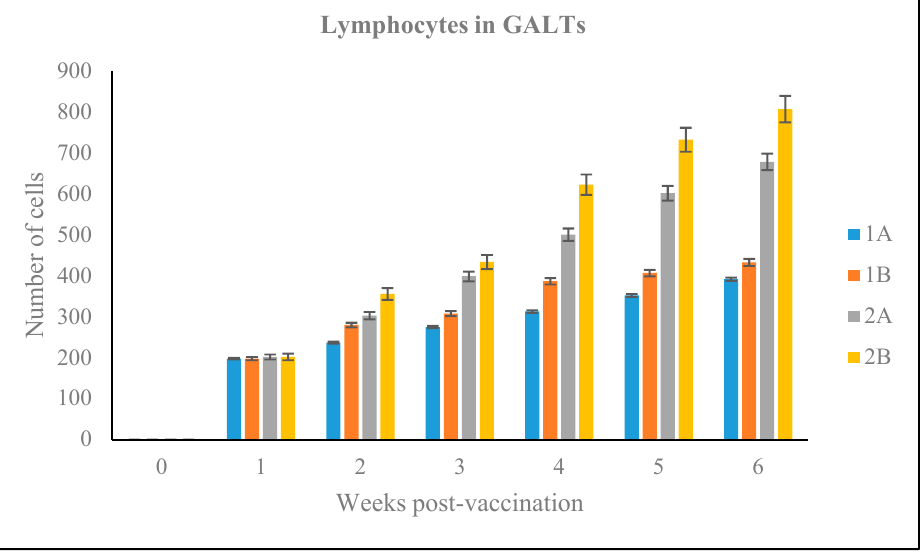
Figure 9. Estimated number of lymphocytes cells in GALT observed in experimental groups during the 6-week vaccination trial.